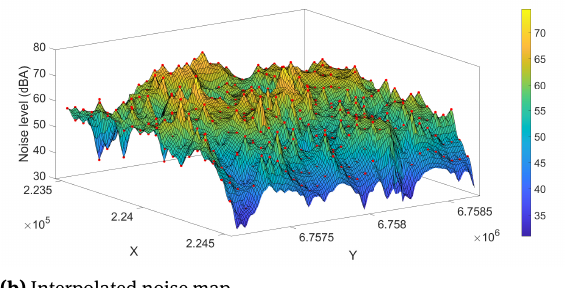
Figure 3: Test site and an example simulated noise-map